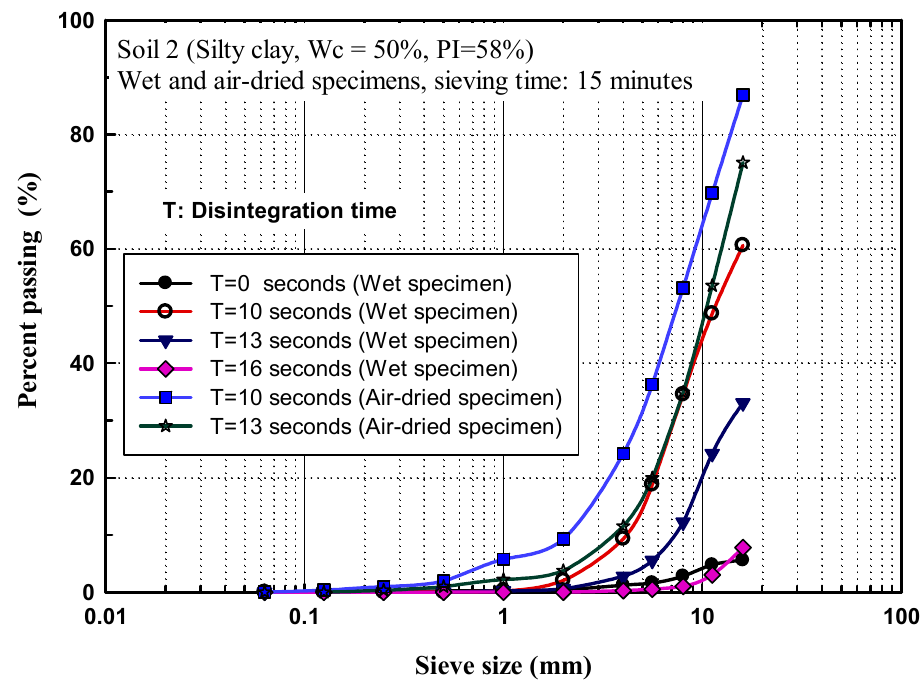
Figure 10. Pass percentage versus sieve size for wet and air-dried specimens prepared at different disintegration times for Soil 2.